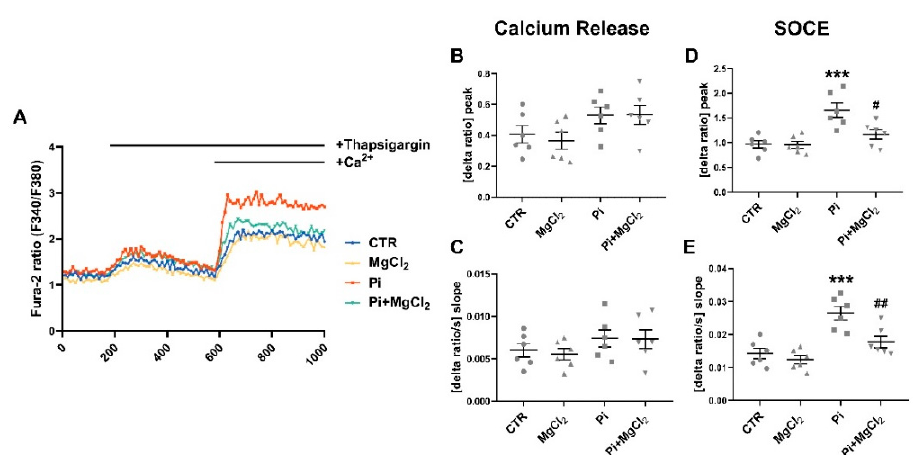
Figure 3. Reversal of ß-glycerophosphate-induced increase in store-operated Ca 2+ entry (SOCE) in megakaryocytes by MgCl 2 . ( A ) Representative tracings of Fura-2 fluorescence ratio in fluorescence spectrometry before and following extracellular Ca 2+ removal and addition of thapsigargin (1 µ M) as well as re-addition of extracellular Ca 2+ in megakaryocytes without (CTR) or with prior 24-h exposure to 1.5 mM MgCl 2 alone (MgCl 2 ), 2 mM ß-glycerophosphate alone (Pi) or 2 mM ß-glycerophosphate and 1.5 mM MgCl 2 (Pi+MgCl 2 ). ( B , C ) Arithmetic means ( ± SEM, n = 6) of peak ( B ) and slope ( C ) increase in Fura-2 fluorescence ratio following addition of thapsigargin (1 µ M) in megakaryocytes without (CTR) or with prior 24-h exposure to 1.5 mM MgCl 2 alone (MgCl 2 ), 2 mM ß-glycerophosphate alone (Pi) or 2 mM ß-glycerophosphate and 1.5 mM MgCl 2 (Pi+MgCl 2 ). ( D , E ) Arithmetic means ( ± SEM, n = 6) of peak ( D ) and slope ( E ) increase in Fura-2 fluorescence ratio following re-addition of extracellular Ca 2+ in megakaryocytes without (CTR) or with prior 24-h exposure to 1.5 mM MgCl 2 alone (MgCl 2 ), 2 mM ß-glycerophosphate alone (Pi) or 2 mM ß-glycerophosphate and 1.5 mM MgCl 2 (Pi+MgCl 2 ). *** ( p < 0.001) indicates statistically significant difference compared to CTR; # ( p < 0.05), ## ( p < 0.01) indicate statistically significant differences compared to Pi alone (ANOVA). CTR, control.